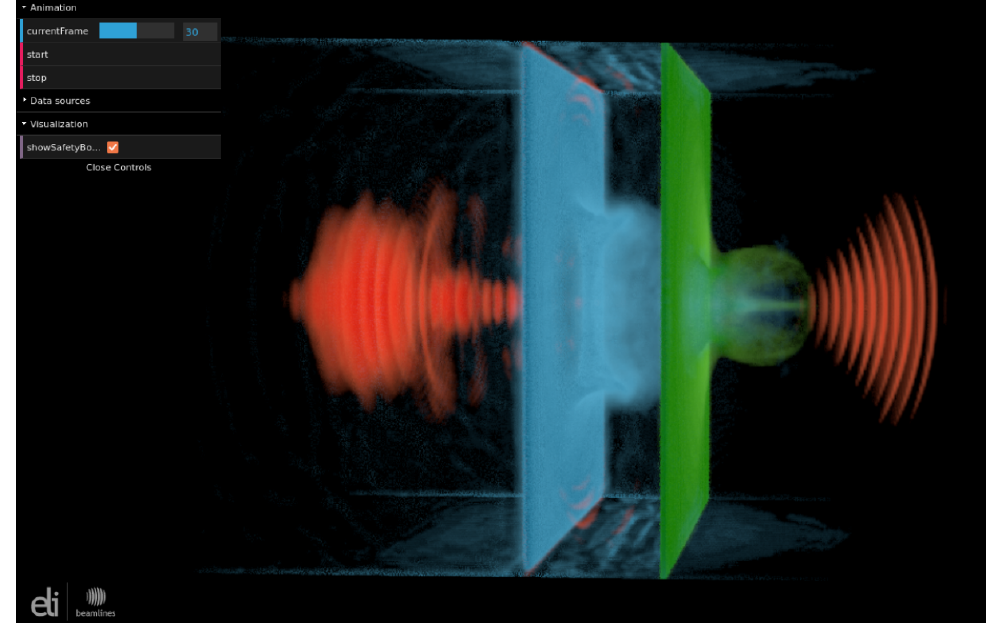
Figure 10. Application of the plasma shutter with a silver target: VBL visualization of our simulation of 1 PW laser (electric field: red color) interacting with the plasma shutter (blue: electron density) and the silver target (green: ion density). Laser pulse is shaped by the plasma shutter (resulting in the aperture) and accelerates ions from the silver target. A high energy ion beam with low divergence is generated. Data used for this visualization come from [79]. The interactive VBL application of the full time evolution is accesible online